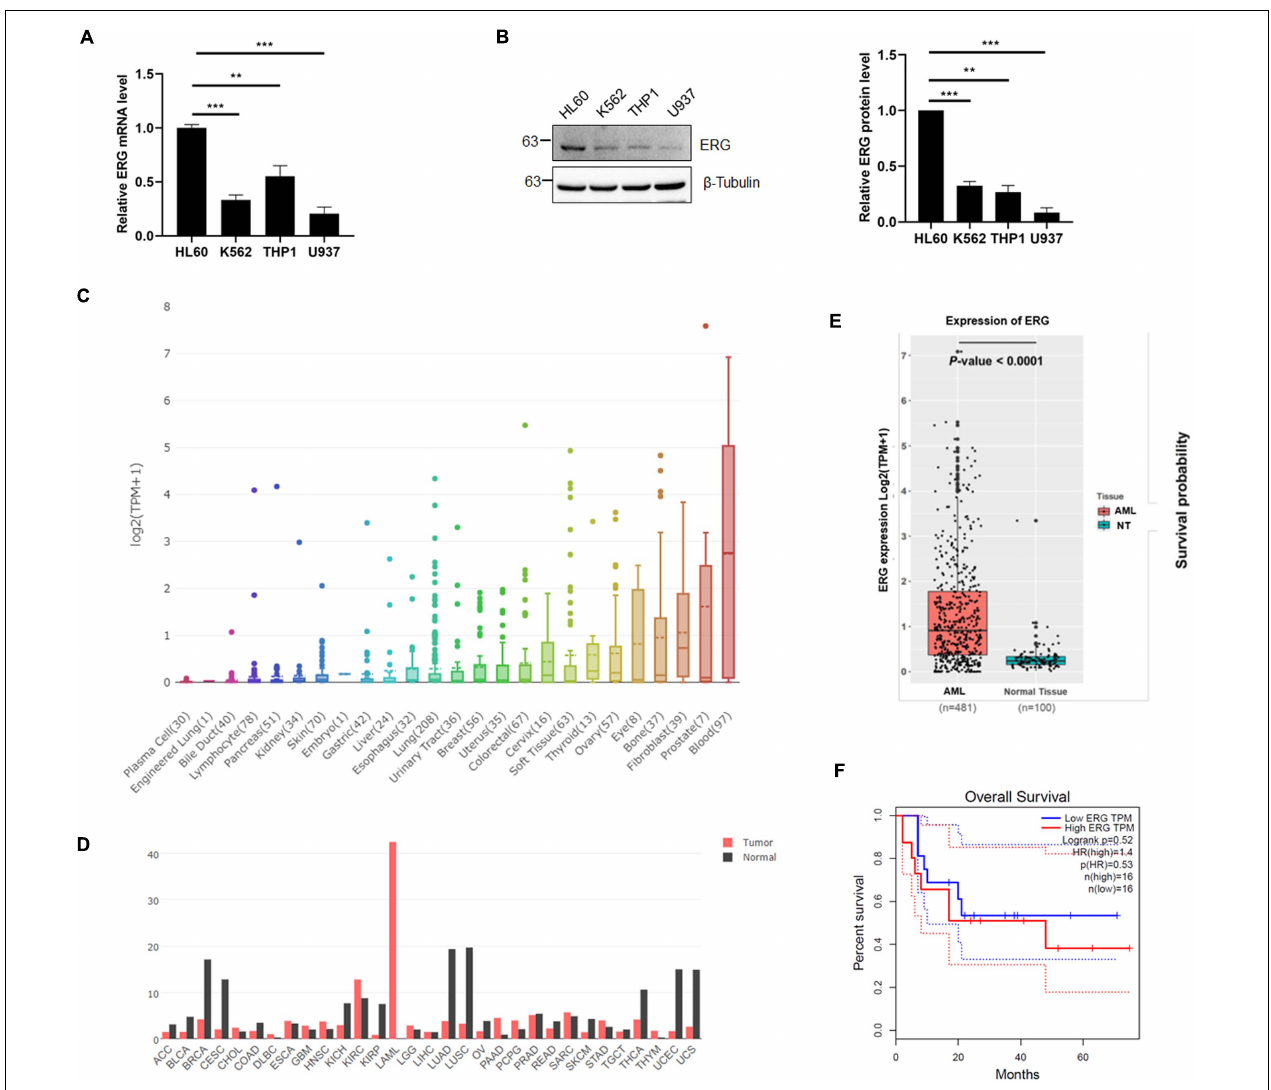
FIGURE 1 | ETS-related gene (ERG) is highly expressed in AML cells and patients. (A) Expression levels of ERG transcripts in various myeloid leukemia cells. The expression levels of ERG transcripts in various myeloid cells were measured by real-time PCR and normalized to HL60 cells ( n = 3 repeats/group, one-way ANOVA, ** p < 0.01, *** p < 0.001). (B) Expression levels of ERG protein in various myeloid cells. The cell lysates from various myeloid leukemia cells were detected by IB with anti-ERG and anti- β -tubulin antibodies (left). The results of quantitative analysis of Western blot are shown in the right panel ( n = 3 repeats/group, one-way ANOVA, ** p < 0.01, *** p < 0.001). (C) The expression levels of ERG transcripts in various tissues in human were analyzed (depmap.org). (D) The expression levels of ERG transcripts in various tumor samples were compared to that in paired normal tissues (http://gepia.cancer-pku.cn/). (E) RNA-seq data was downloaded from the TCGA leukemia dataset, and the mRNA expression levels of ERG in AML and normal tissues were analyzed by R language. (F) ERG overexpression is not associated with prognosis. Patients whose ERG expression levels were one normalized standard deviation above and below the mean level were grouped as high ERG and low ERG,